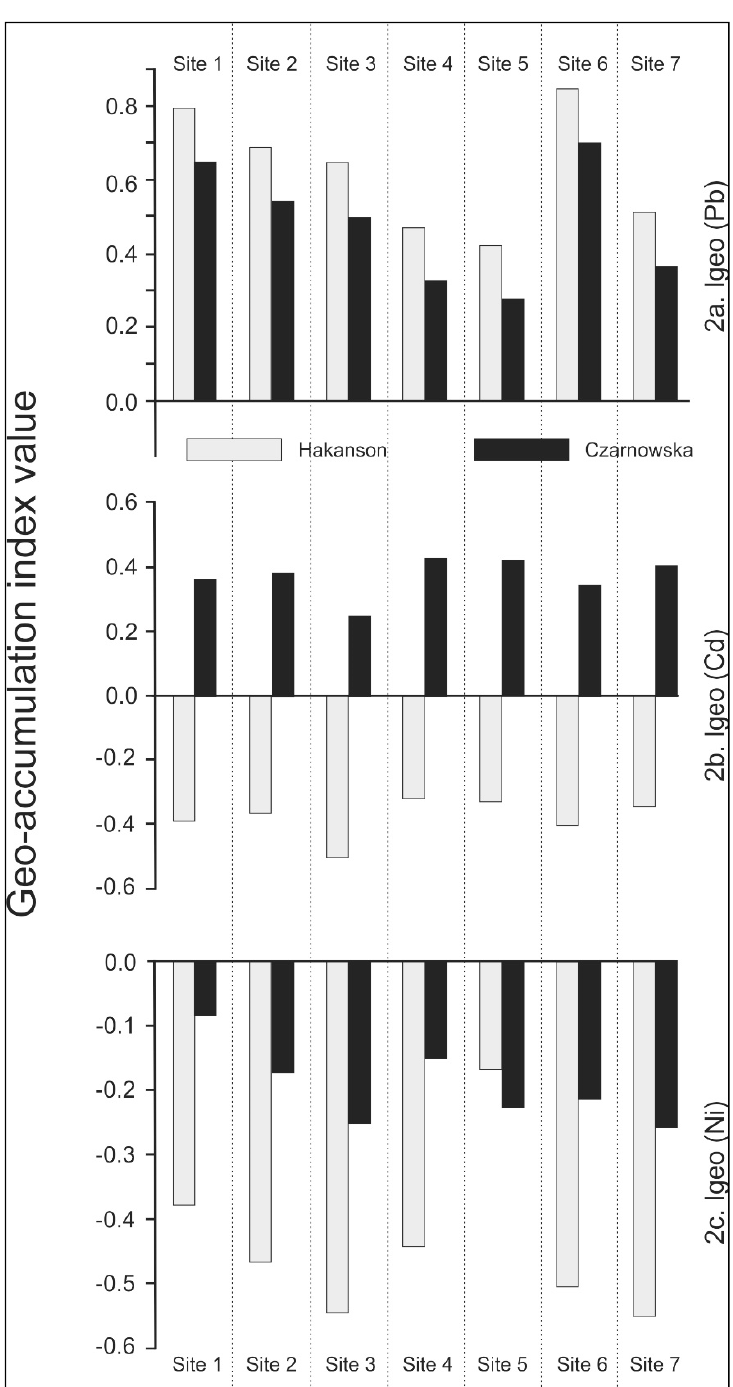
Figure 2. Site distribution of (a) Pb, (b) Cd, (c) and Ni geo-accumulation indices within the Kampinoski National Park ( I geo assayed on the basis of Håkanson and Czarnowska background values, Table 1).